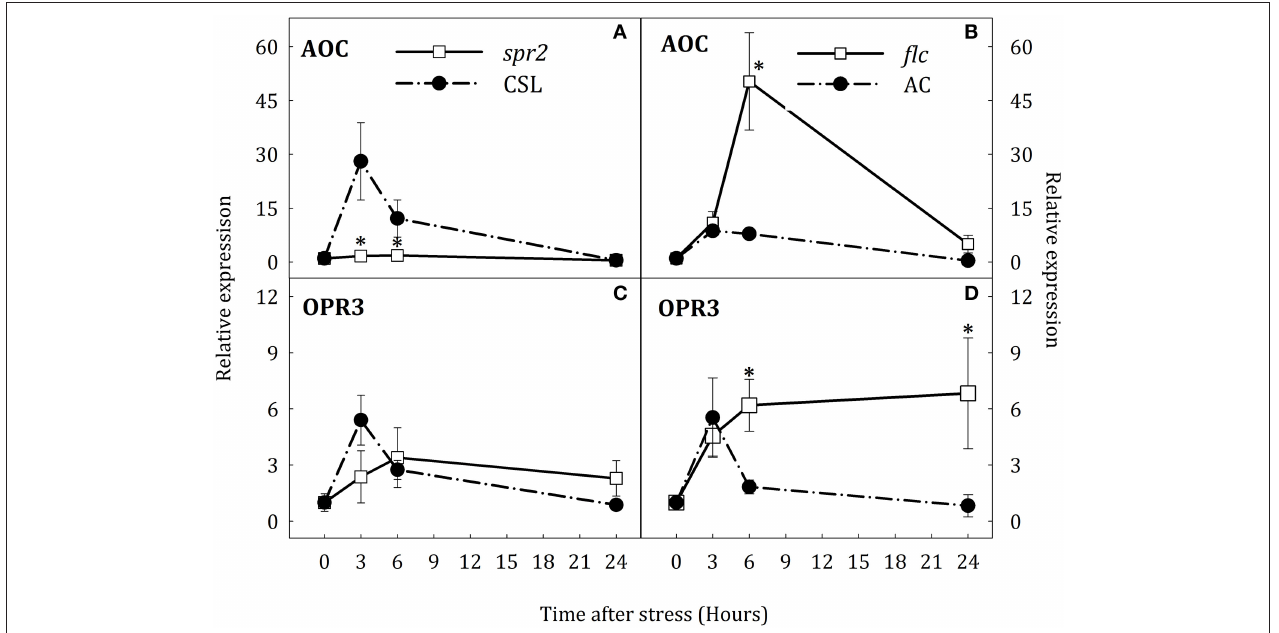
FIGURE 6 | Relative expression of AOC (A,B) and OPR3 (C,D) in leaves of Solanum lycopersicum [WT (CSL and AC, black circles) and mutants ( spr2 and flc , white square)] under control ( t = 0 ) and water-stress conditions. Data are mean values ± standard deviation of three independent determinations. Asterisks denote statistical difference with respect to WT at p ≤ 0.05